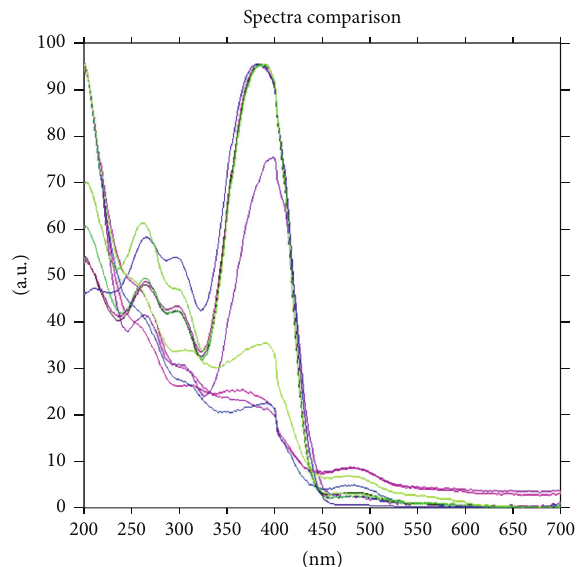
Figure 6: Peak-purity spectra of thiocolchicoside recovered after degradation in 1MHCl, 0.5 MNaOH, 1%v/v H 2 O 2 , degradants and thiocolchicoside standard scanned at peak-start, peak-apex and peak-end